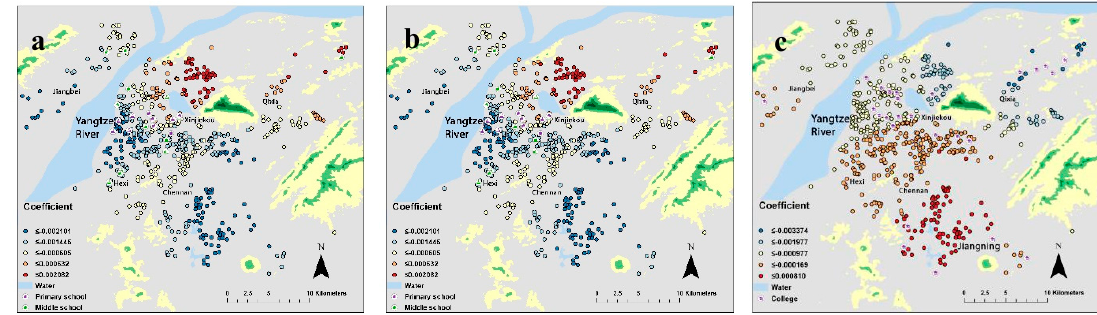
Figure 3. The spatial distribution of coefficients: ( a ) commercial centers; ( b ) primary and middle schools; ( c ) colleges and universities.